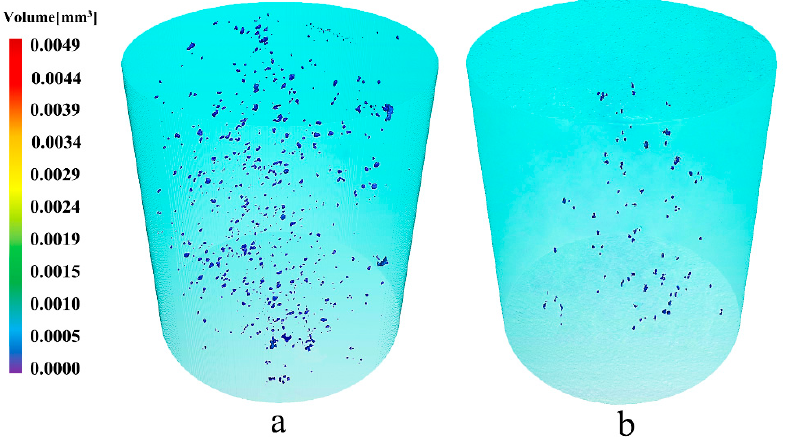
Figure 2. Three-dimensional pore diagram of the fabricated specimens before ( a ) and after ( b ) the remelting process. remelting